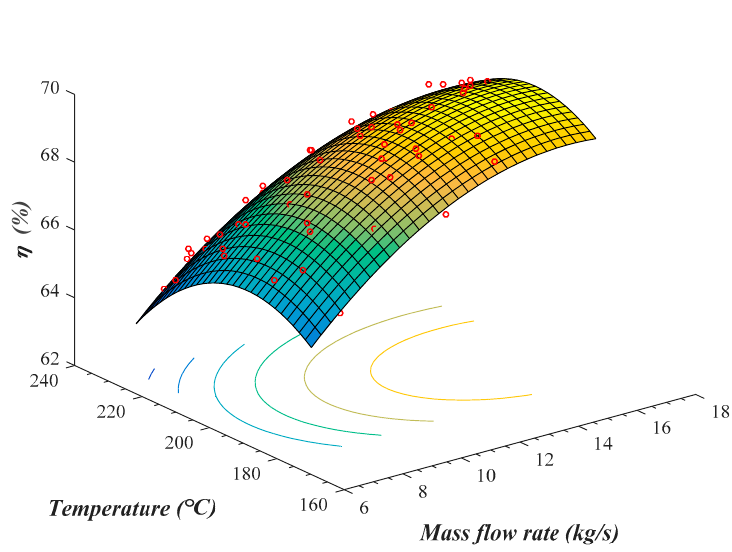
Figure 16. The fitted surface on the empirical data obtained from the boiler. Table 5. The optimal boiler efficiency (obtained from the RSM).